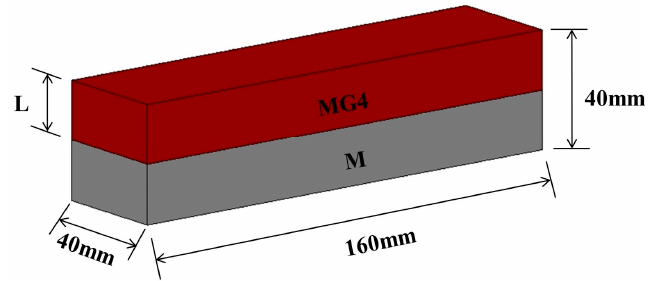
Figure 1. Geometry of layered cement mortar